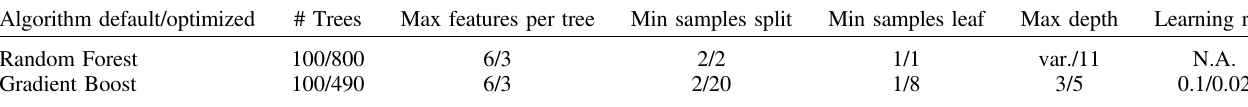
Table 1. Default and Bayesian optimized parameters for the random forest and gradient boosting algorithms, learning rate is not a hyperparameter of the random forest algorithm, minimum impurity decrease was also optimized but did not show a change from 0.0, variable max depth of the default random forest is de fi ned as the expansion of tree until endpoints contain less than [min_samples_split] samples.